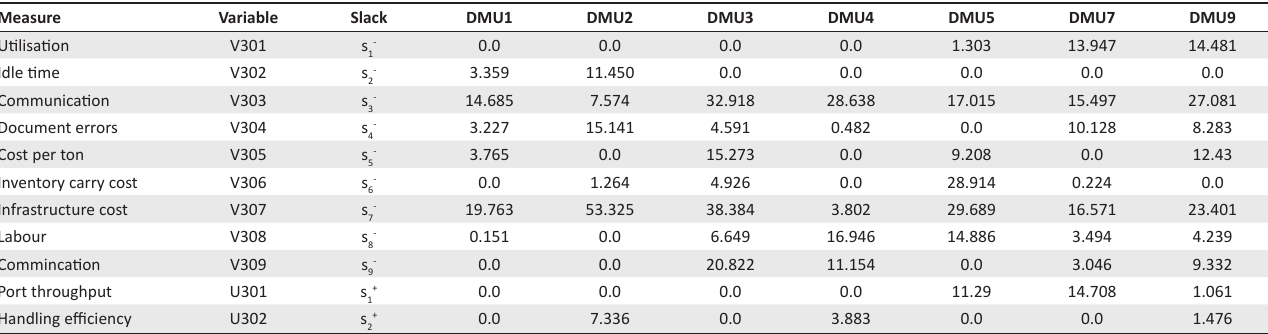
TABLE 2: Mine node slacks analysis results. Measure